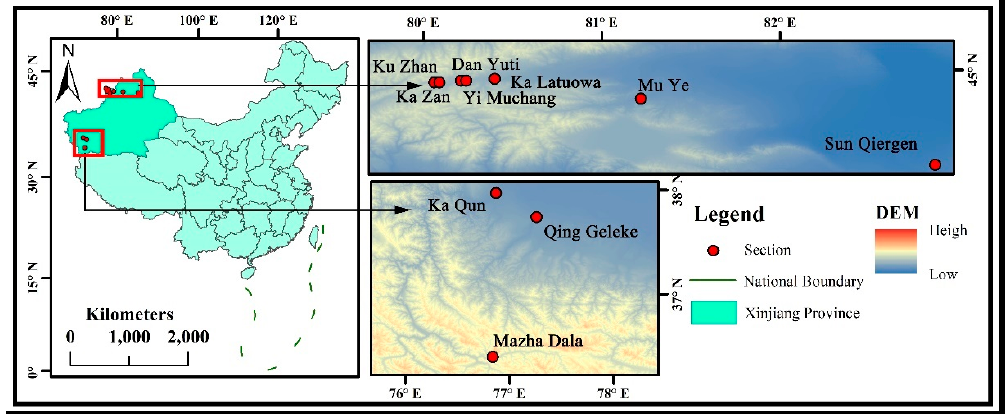
Figure 2. Sections of ten rivers in Xinjiang, China. The Ka Qun (KQ), Mazha Dala (MD), and Qing Geleke (QG) rivers are near the south, whereas the Ku Zhan (KZ), Ka Zan (KZan), Dan Yuti (DY), Yi Muchang (YM), Ka Latuowa (KL), Sun Qiergen (SQ), and Mu Ye (MY) are near the north of Xinjiang province.